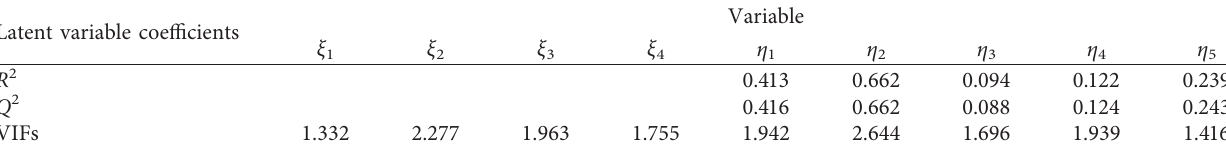
Table 6: The assessment of the predictive validity and multicollinearity for latent